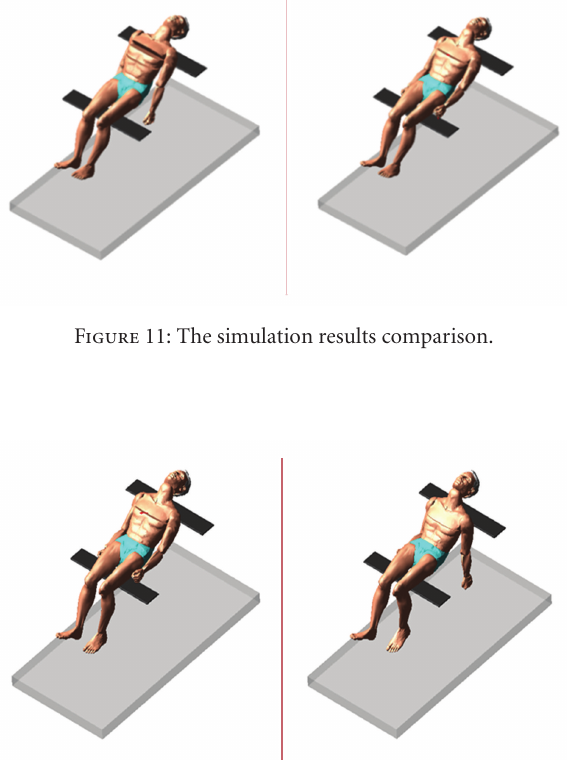
Figure 10: The dynamic analysis results.